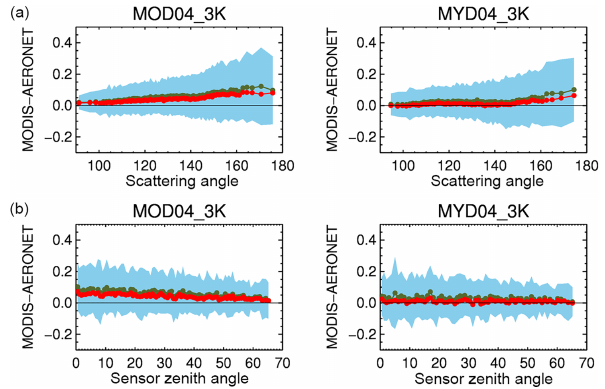
Figure 8. Same as Fig. 6 except for scattering angle (a) and sensor zenith angle (b)